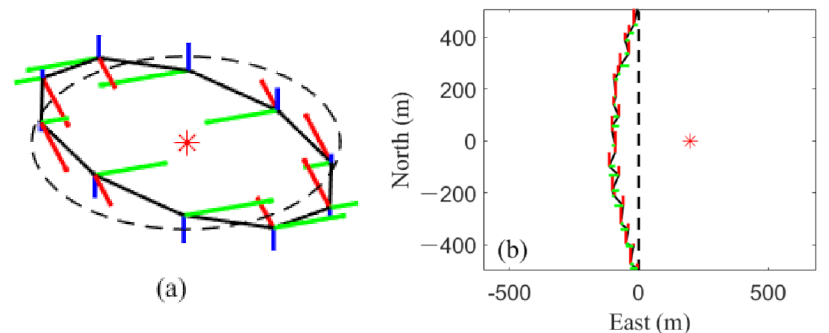
Figure 3. Inexact transmitter geometry and its representation with electrical dipoles. ( a ) ATEM: an airborne transmitter loop tilts from its leveled position (dashed black lines). ( b ) SATEM: a ground transmitter wire deviates from the straight path (dashed black lines). The solid black indicates the actual transmitter wire path represented by many segments of electric dipoles. The blue, red, and green denote the orthogonal decomposition of each electric dipole to the x -, y -, and z -directions, respectively. The red asterisk represents the